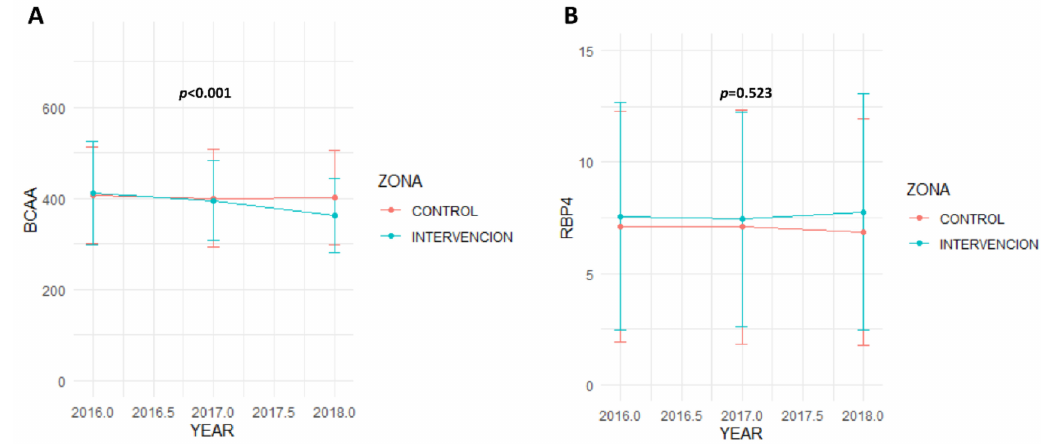
Figure 4. BCAA and RBP4 variation over time, depending on the group. BCAA: branched amino acid. RBP4: retinol-binding protein 4. The p -value, which compares BCAA variation ( A ) or RBP4 variation ( B ) over time depending on the group, was calculated by ANOVA